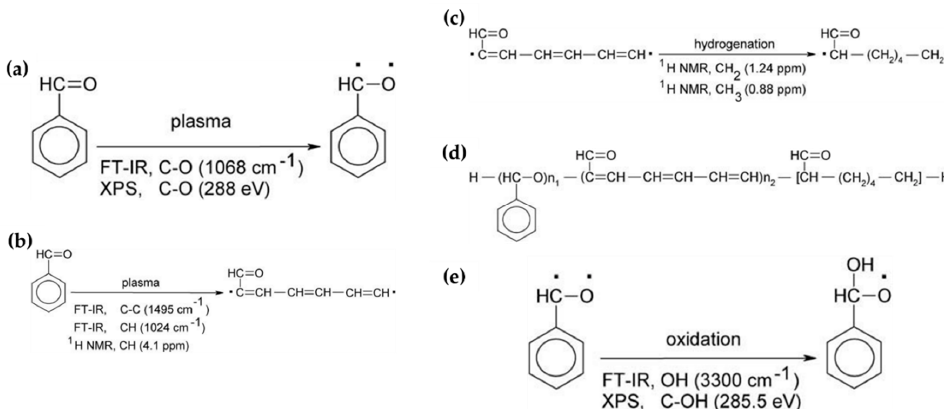
Figure 15. Chemical structures identified via characterization of benzaldehyde-based polymer films using APP techniques, where ( a ) depicts benzaldehyde radical generation by π bond breakage from aldehyde, ( b ) depicts aliphatic chain production by aromatic ring breakage, ( c ) depicts hydrogenation of the aliphatic chain, ( d ) depicts the recombination process between benzaldehyde radicals and aliphatic chains, and ( e ) depicts benzaldehyde radical oxidation under plasma conditions [118].